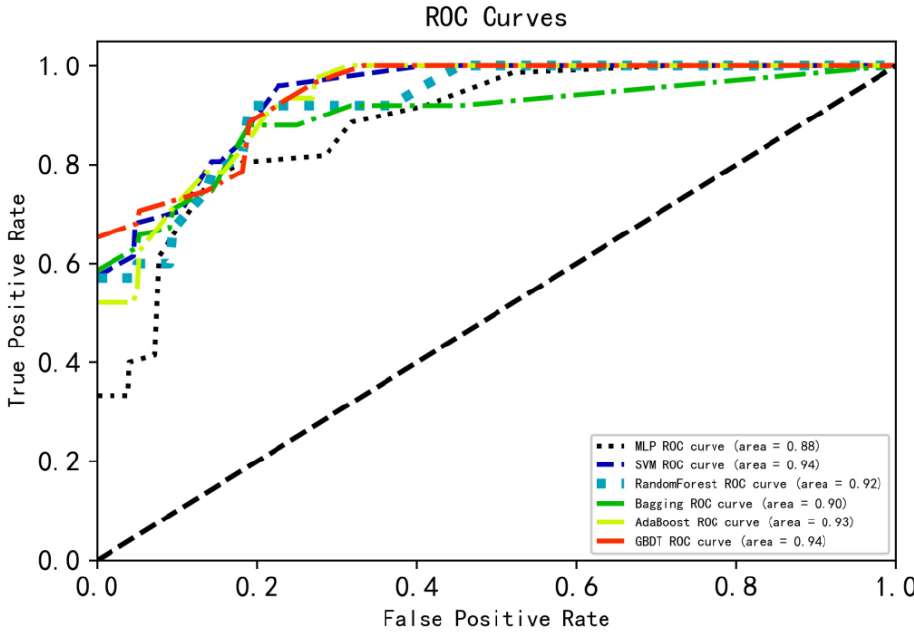
Figure 12. ROC curves for six machine learning algorithms using REF-Top20 by k-fold cross-vali- dation.